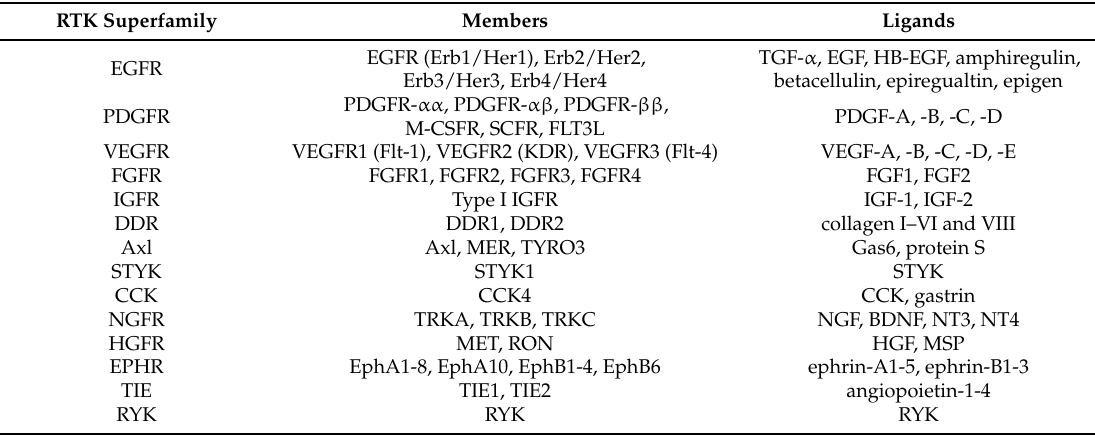
Table 1. Classification of receptor tyrosine kinases (RTKs) superfamilies and